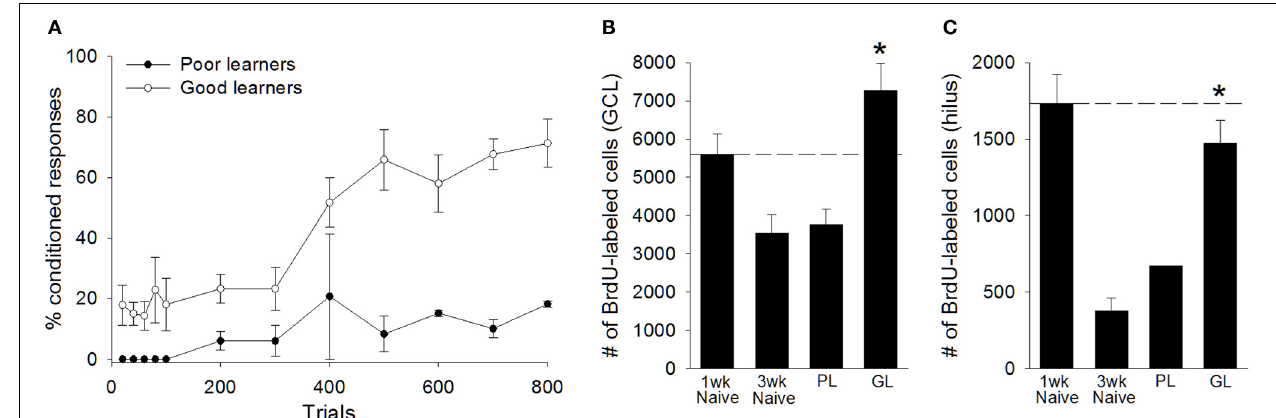
FIGURE 5 | Learning, not merely training, prevented the death of cells in the peri-pubescent dentate gyrus. (A) Trained animals were separated into “poor learners” ( N = 2) and “good learners” ( N = 7), based on their performance during trace conditioning. Good learners consistently outperformed poor learners. Poor learners, which failed to acquire the conditioned response, retained significantly fewer BrdU+ cells than naïve animals perfused 1week after the BrdU injection ( N = 6). Moreover, poor learners and naïve animals perfused three weeks after the BrdU injection retained a comparable number of cells, indicating that, in poor learners, the